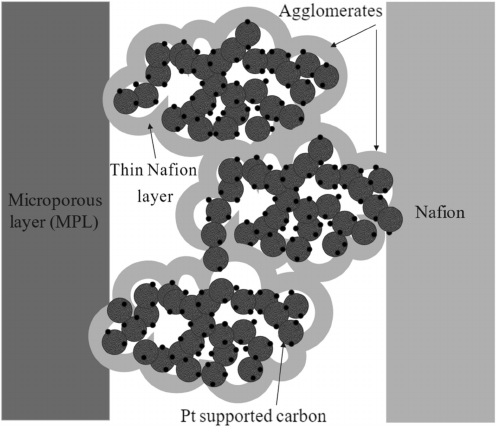
Figure 7. A schematic of the catalyst layer, membrane, and microporous layer indicating the agglom- erates inside the catalyst